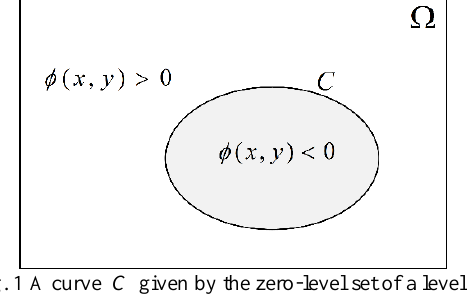
Fig. 1 A curve C given by the zero-level set of a level set function ),,( tyx